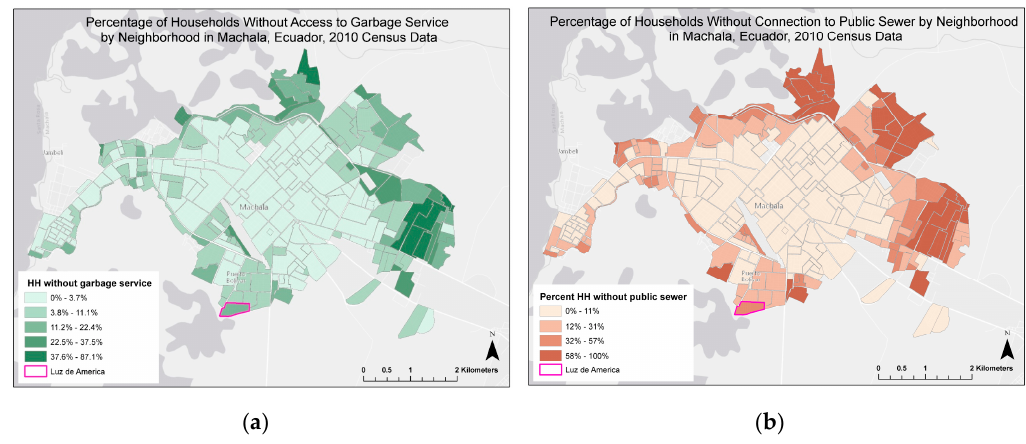
Figure 1. Location of study site in Machala, Ecuador. Luz de America indicated with neighborhood level census information from 2010 data: ( a ) Percentage of households without access to garbage service (21.2% for Luz de America) and ( b ) without connection to public sewerage system (37.7% for Luz de America). Data source: Instituto nacional de estadistica y censos (INEC). Neighborhood map source: National Institute of Meteorology and Hydrology of Ecuador (INAMHI).